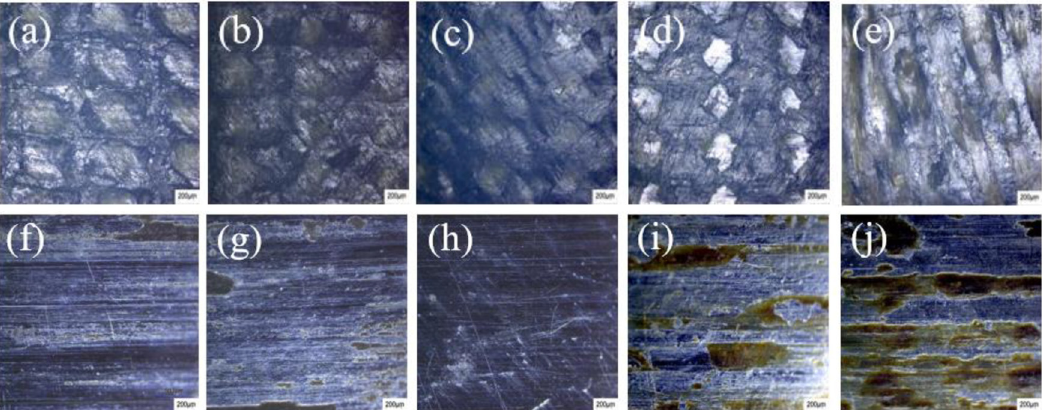
Fig. 7. LSCM diagram of spherical plain bearing after friction and wear (a – e is the wear surface of the liner at 25, 55, 85, 115, 145 ° C; f – j is the wear surface of the inner ring at 25, 55, 85, 115, 145 ° C).